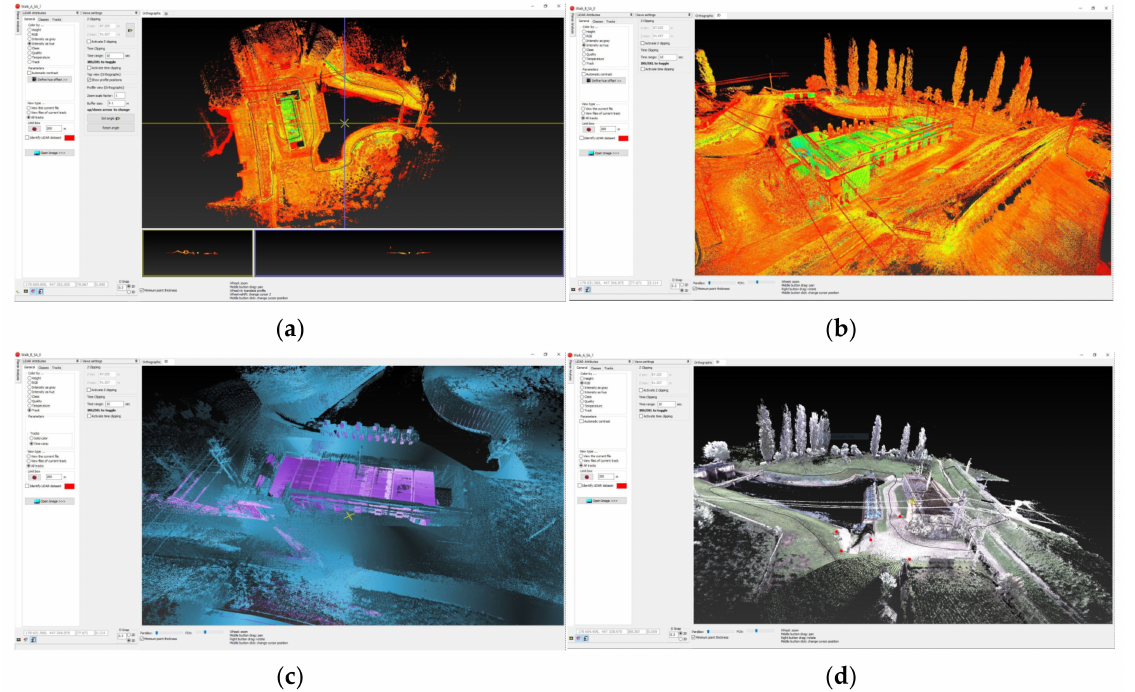
Figure 32. Cruceni pumping station, Timis , Romania, scanning performed on 03 June 2019: ( a ) Inten- , sity of the nuance of LiDAR data, orthographic visualization; ( b ) The nuance intensity of the LiDAR data, 3D visualization; ( c ) Coloring of point clouds after walks; ( d ) View point clouds